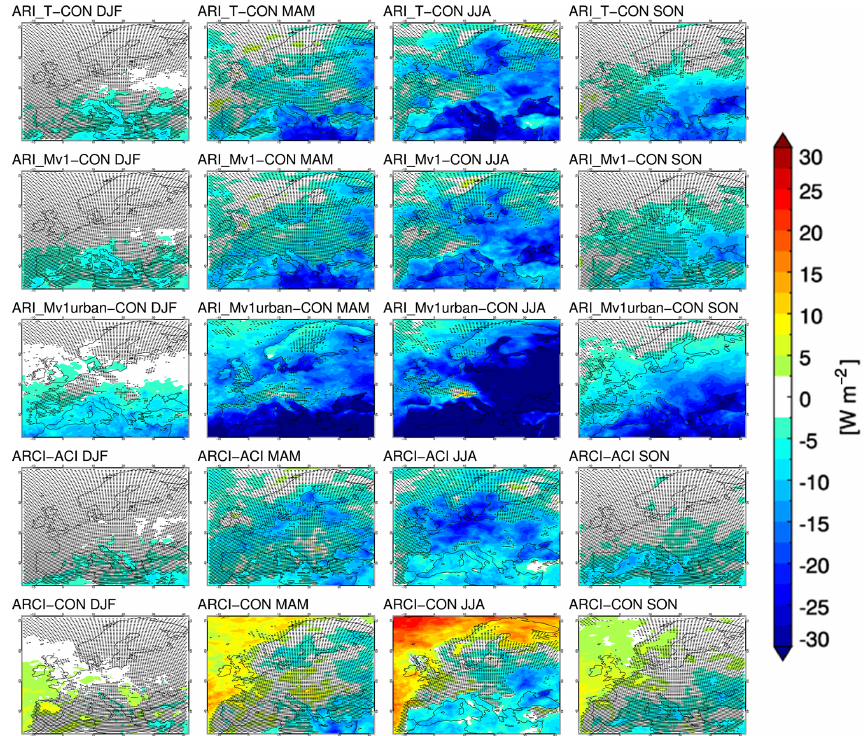
Figure 5. Radiative effect (RE) for all seasons. Rows 1–3: for selected ARI group simulations (ARI_T, ARI_Mv1, ARI_Mv1urban) that implement only aerosol–radiation interactions. The RE has been calculated as the difference in net shortwave radiation at the surface from control CON and depicts the impact of aerosol–radiation interactions only. The fourth row depicts the aerosol–radiation interactions in an environment where the indirect effect is also present and displays the difference of experiment ARCI to ACI. The bottom row depicts the impact of aerosol–radiation interactions plus the impact of the TE2014 microphysics scheme with aerosol–cloud interactions. It displays the difference of experiment ARCI to CON. Stippling indicates areas where the differences are not statistically significant at the 95% level, according to the Mann–Whitney non-parametric